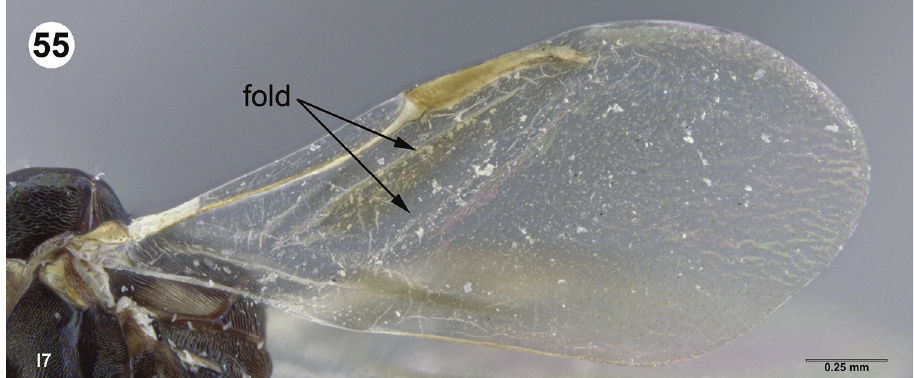
Figure 55. Ivieosema limula . Holotype female: fore